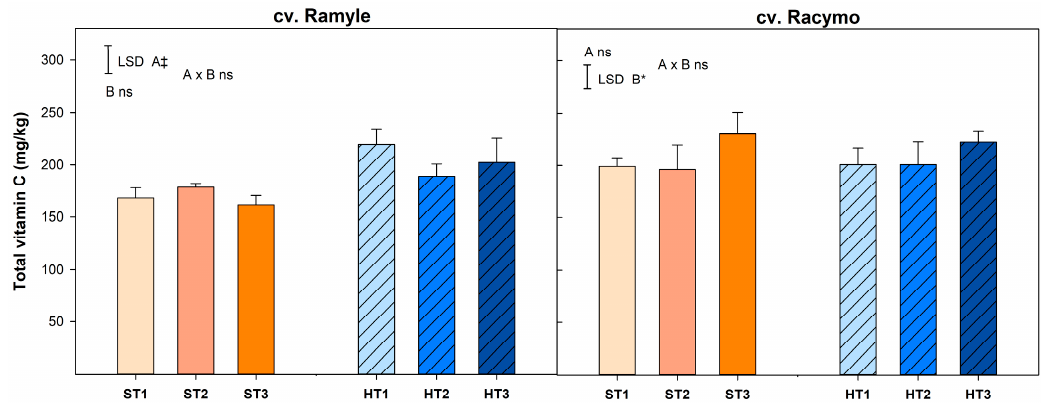
Figure 6. Total vitamin C content of two tomatoes (cvs. Ramyle and cv. Racymo) under different irrigation treatments (T1: desalinated seawater with low electrical conductivity (EC); T2: well / desalinated water, intermediate EC; and T3: well water with high EC) and cultivation systems (traditional soil system, S; hydroponic, H) ( n = 3 ± SD). The uppercase letters A and B denote cultivation system and irrigation treatment, respectively. ns, *, and ‡ significance for p ≤ not significant, 0.05, and 0.001, respectively.